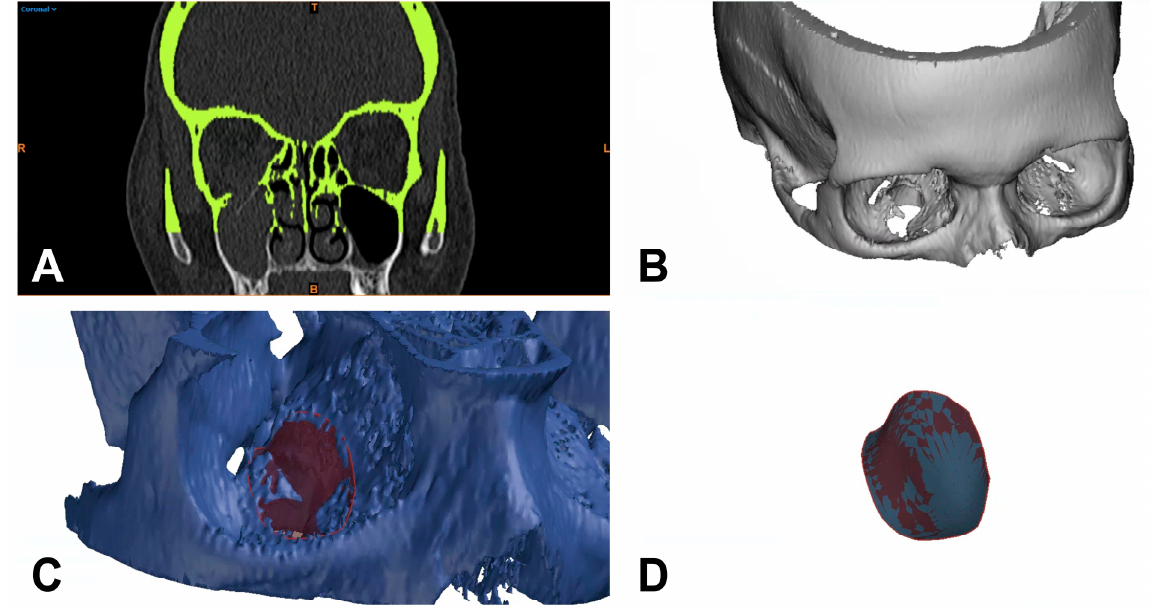
Figure 2. Separation of bony structures using thresholding of Hounsfield units and virtual tissue dissection ( A ), generation of a 3D model ( B ), and construction of a polynomial surface circularly around the defect for 3D-based defect measurement ( C , D ). R = right; T = top; L = left; colored B = bottom.